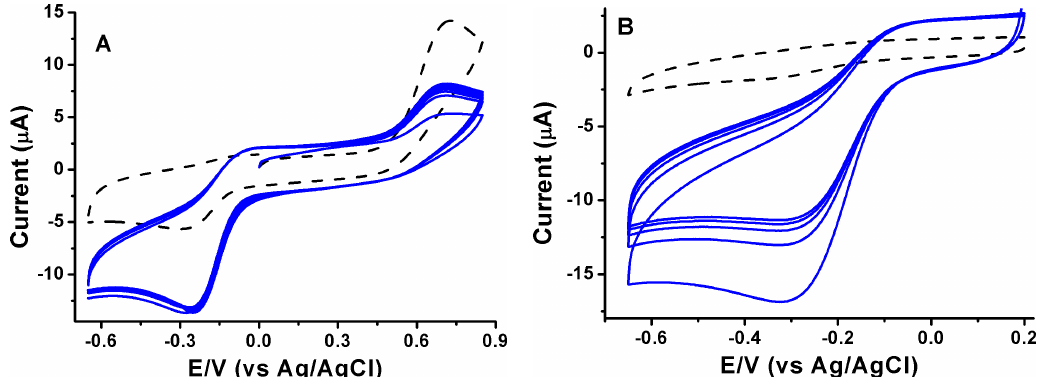
Figure 3. Continuous scan CVs recorded at 50 mV s − 1 with the tTGNEE–Anti-tTG–secAb-HRP in 1 mM H 2 Q, 0.05 M PBS (pH 7.4) before (dash line) and after (solid lines) addition of 1.5 mM H 2 O 2 : ( A ) in the potential window − 0.65 to 0.90 V, initial potential 0.0 V, initial scan direction: positive; ( B ) in the potential window − 0.65 to 0.20 V, initial potential 0.20 V, initial scan direction: negative.